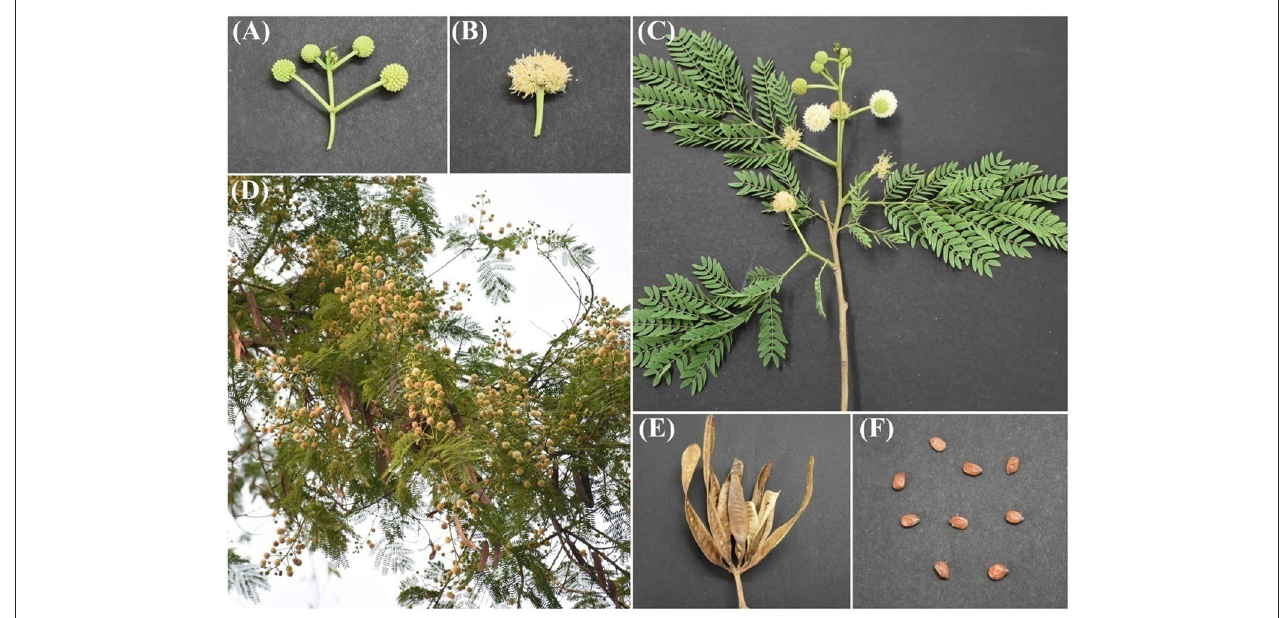
FIGURE 1 | Physical characteristics of Leucaena leucocephala , (A) reproductive buds, (B) Inflorescence, (C,D) Flowering shoot, (E) Mature pods, (F) Seeds.